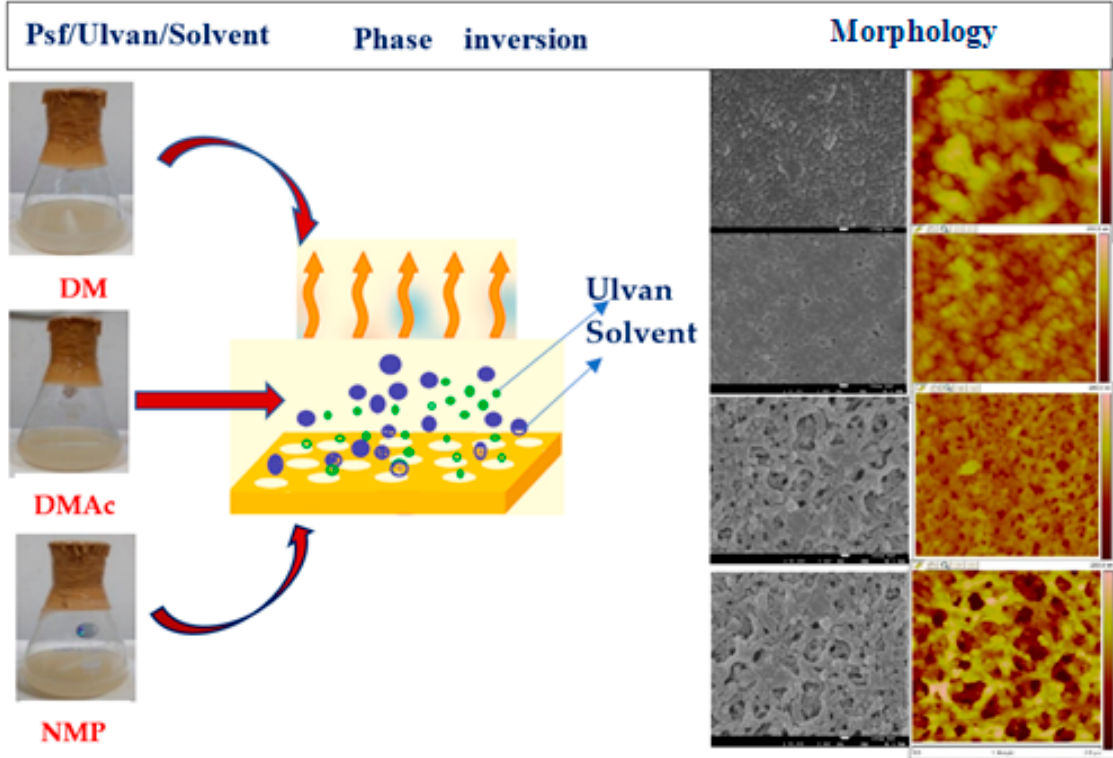
Figure 17. PSF/ ulvan /DMF membrane fabrication and morphology [86].